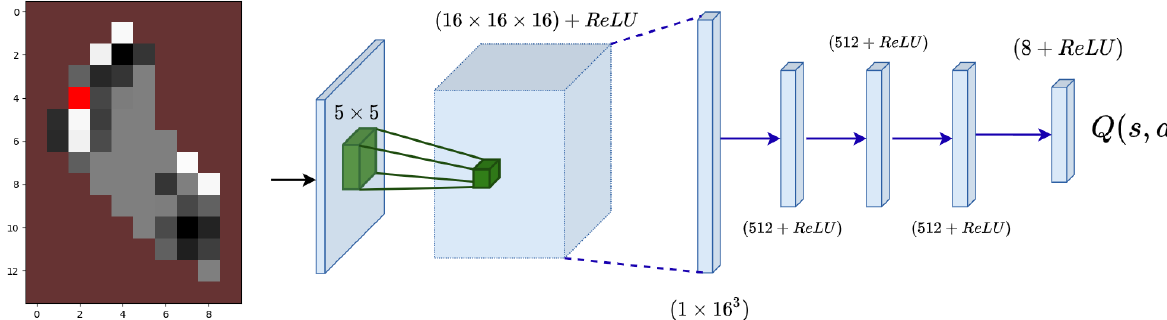
Figure 10. In the left, the state of the environment. In red, the agent position. In brown the land cells. In gray scale, the visitable zones. In the right, the Convolutional Neural Network. The convolutional layers converge in dense layers using the Re-LU function as an activation layer for every